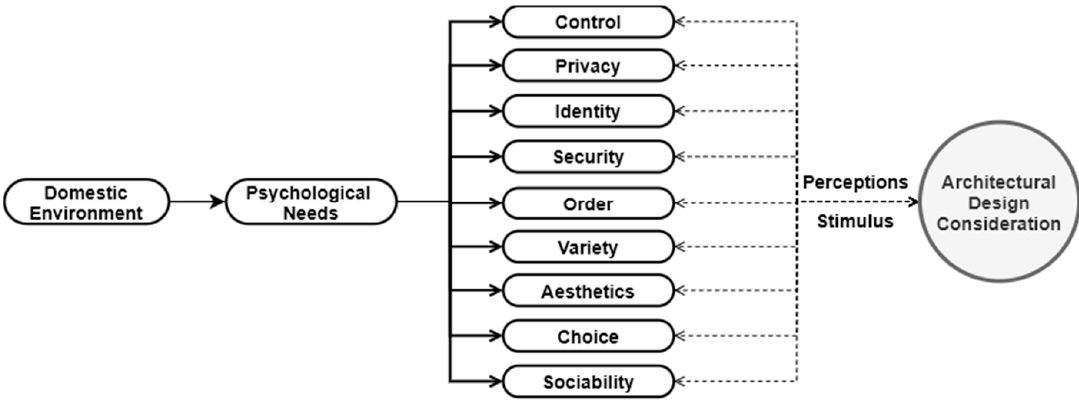
Figure 9. Human psychological needs for architectural design consideration [13,15,17,49,85].